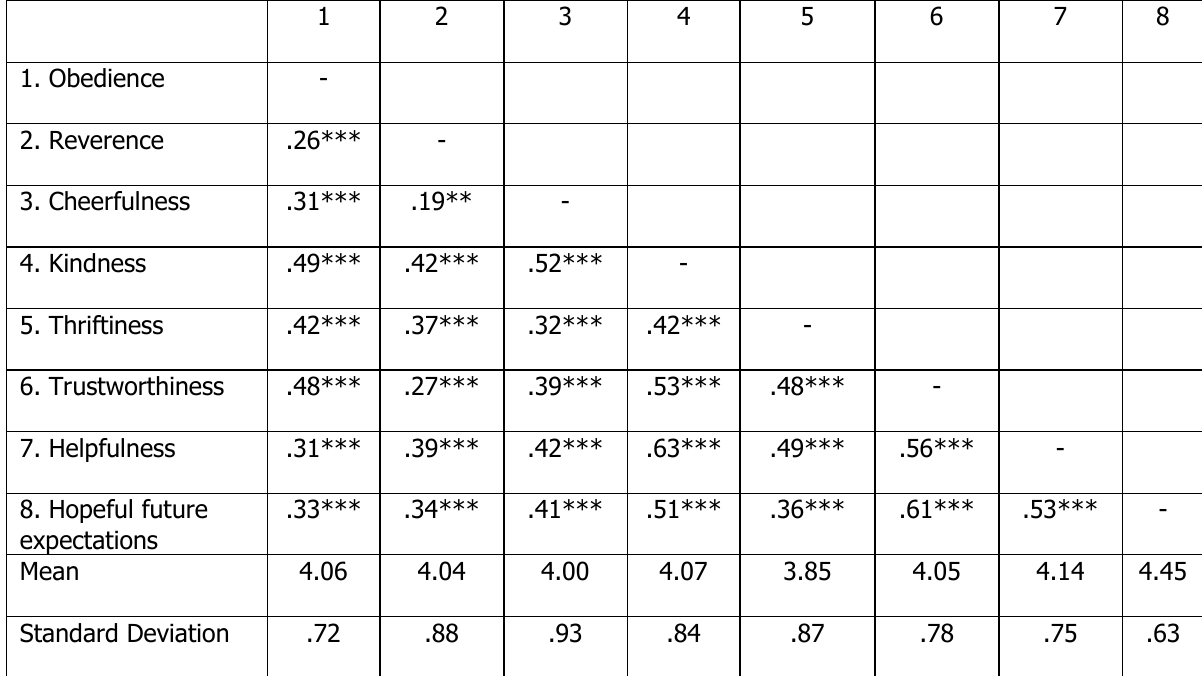
Descriptive Statistics and Correlations for Key Study